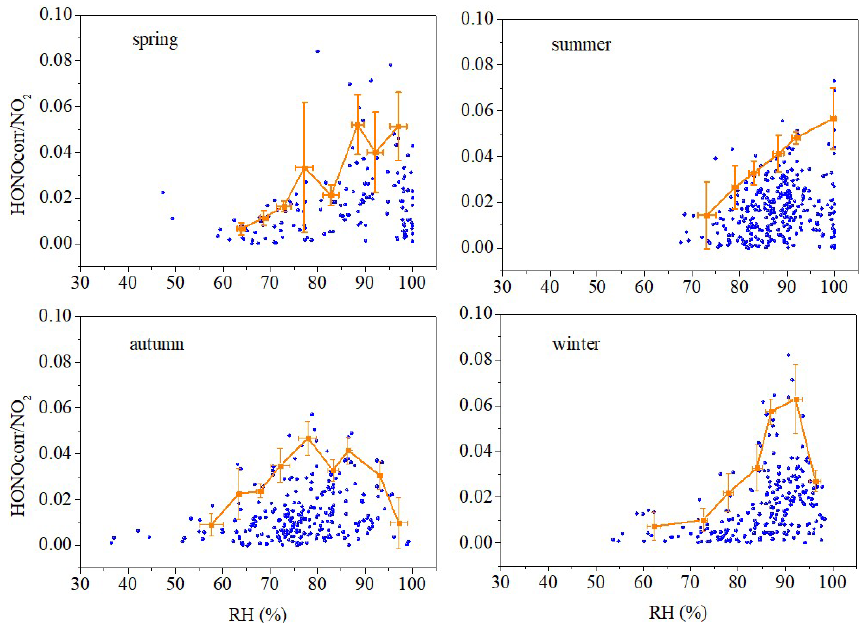
Figure 5. Scatter plots of nighttime HONO corr / NO 2 ratios versus RH. The average top-five HONO corr / NO 2 in every 5% RH interval are shown as orange squares, and the error bars show ± 1